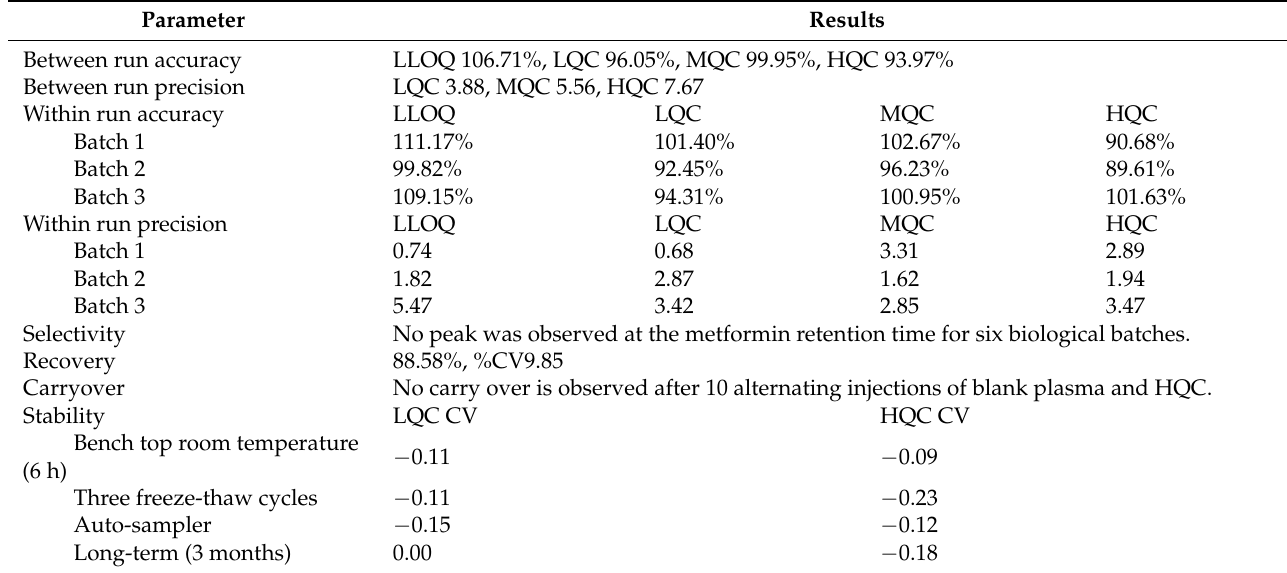
Table 2. Bioanalytical validation parameters for